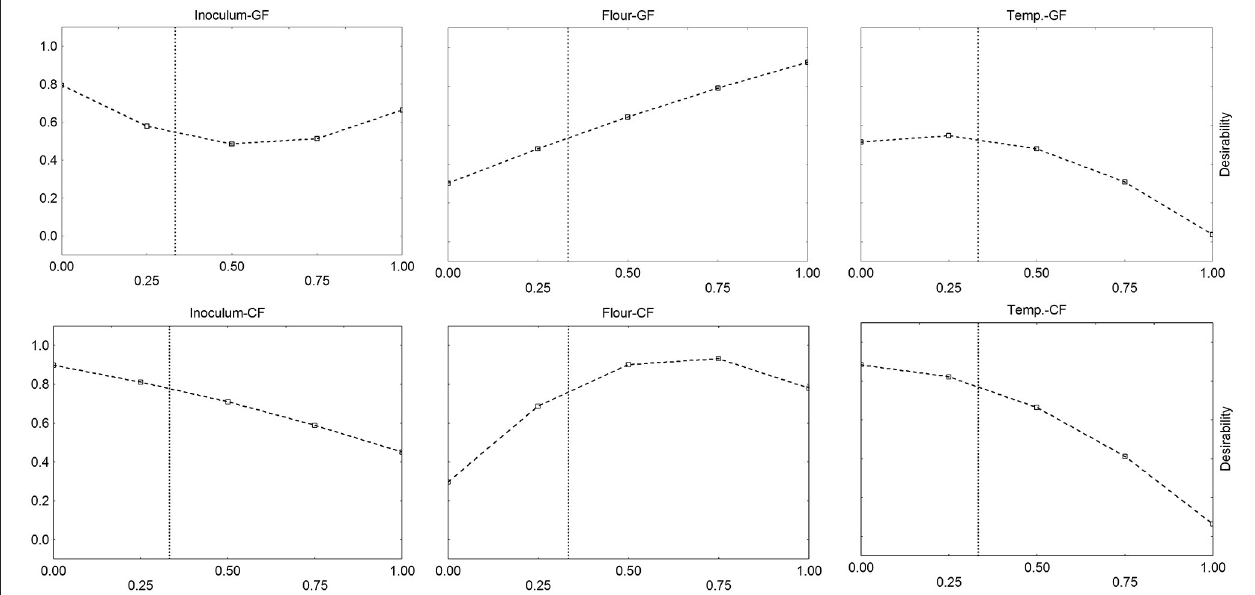
FIGURE 5 | Desirability profiles for the effect of flour (F), inoculum (I), and temperature (T) on the acidification (parameter 1 pH max ) of L. delbrueckii subsp. bulgaricus . GF, Gluten Friendly Flour; CF, Control Flour.